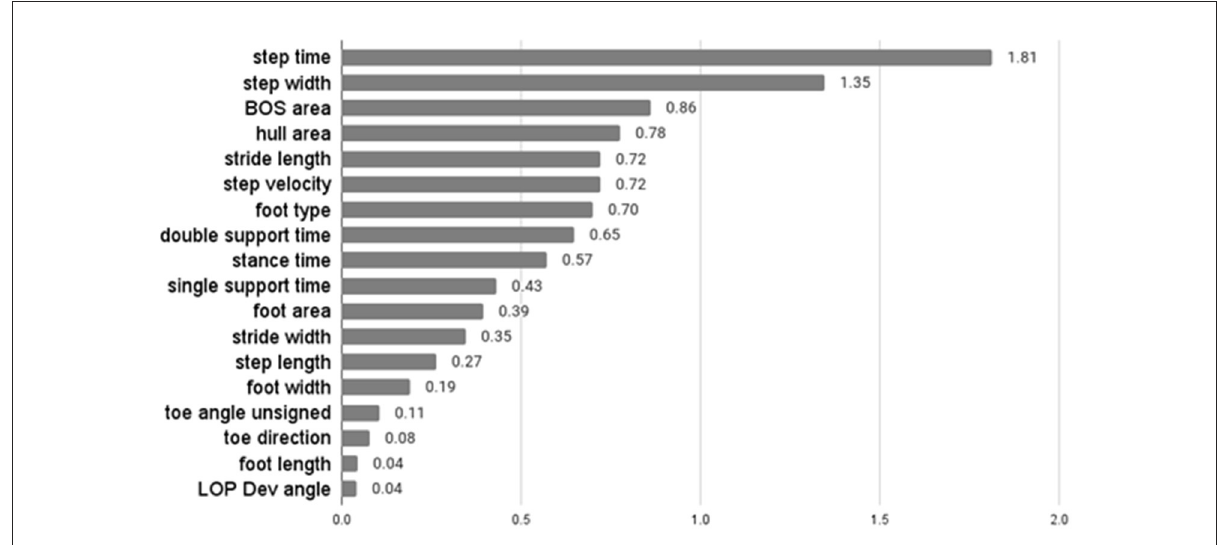
FIGURE3 Absolute values of feature coefficient of